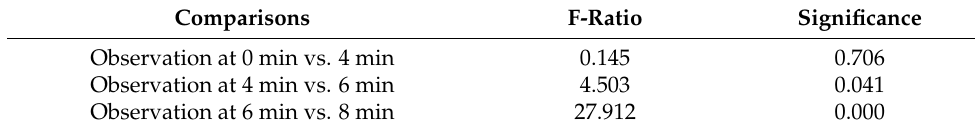
Table 2. Comparison of skin color (F-ratio) across four periods of